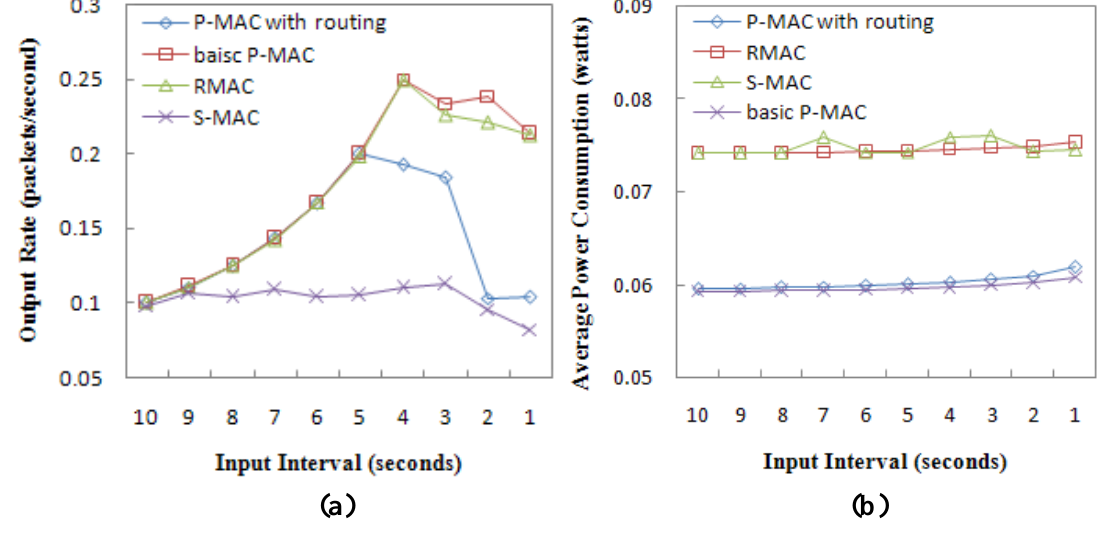
Figure 11. (a) Throughput in the random topology. (b) Average power consumption per sensor node in the random topology.